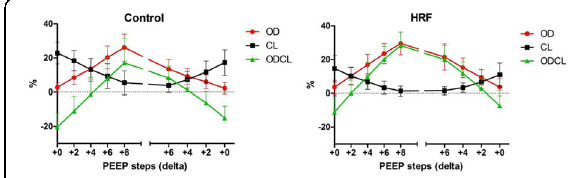
Fig. 1 (abstract 001357). Changes in percentages of OD (red), CL (black) and ODCL (green) in patients with HRF and healthy control patients during an incremental and decremental PEEP